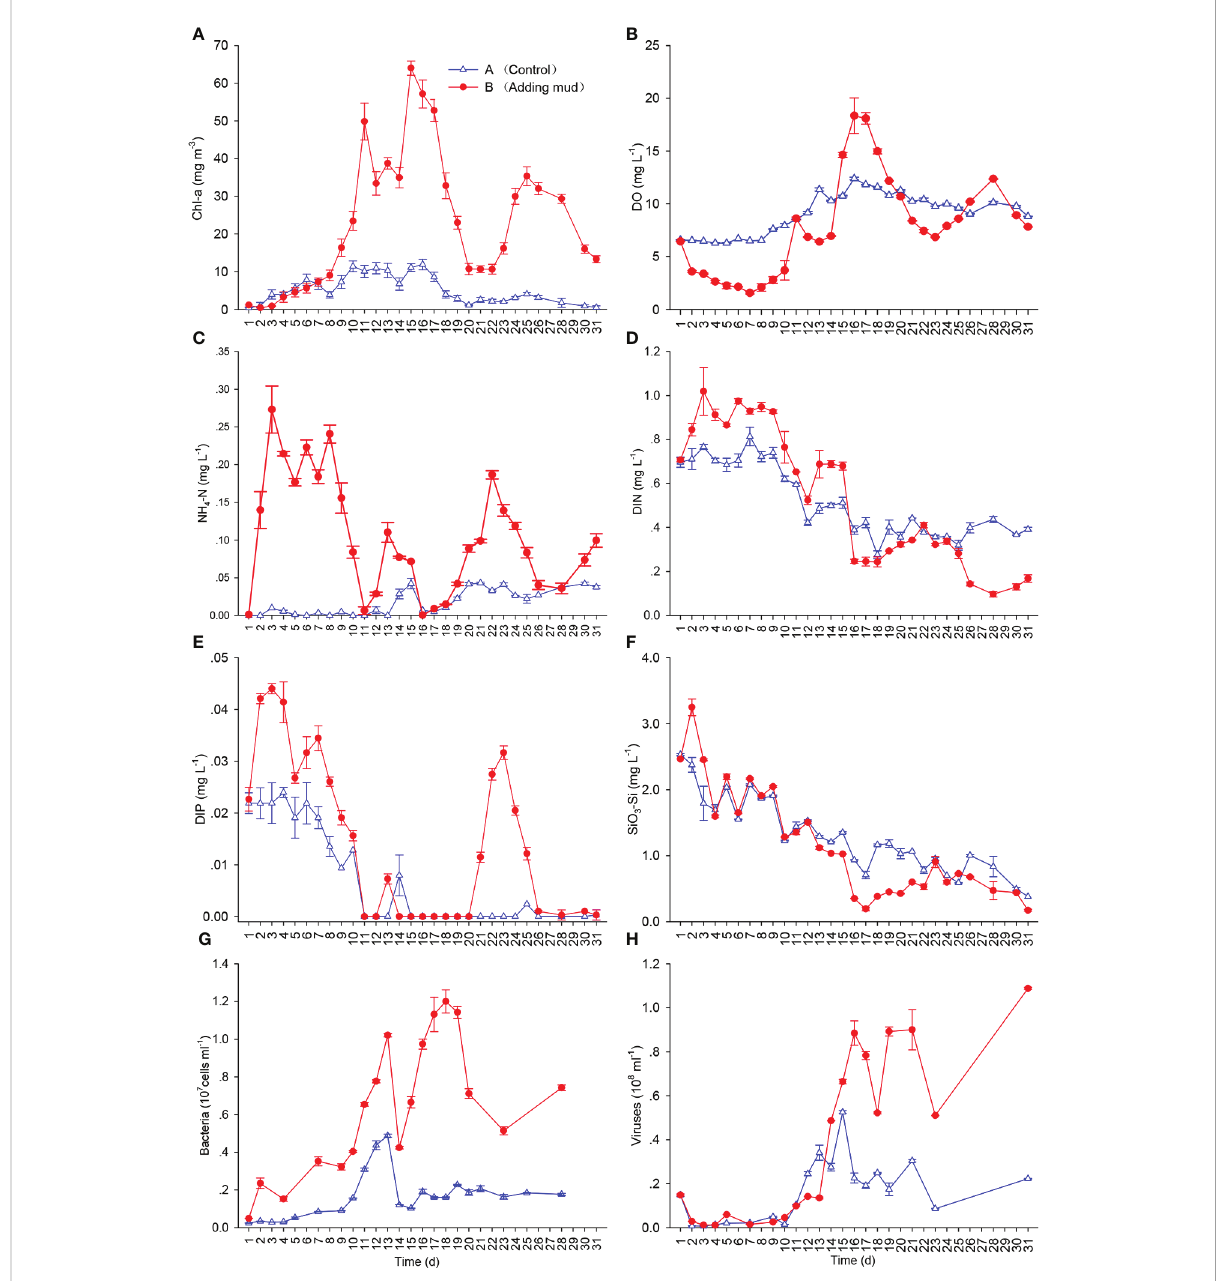
FIGURE 2 Concentrations of Chl-a (A) , DO (B) , NH4-N (C) , DIN (D) , DIP (E) , and SiO 3 -Si (F) and abundances of bacteria (G) and viruses (H) during the experiment (Mean ±